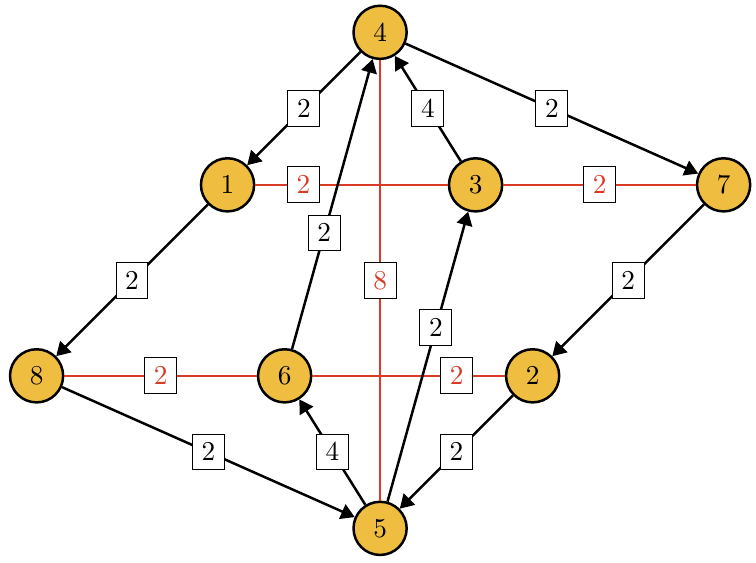
Figure 20 . Quiver diagram for phase D of Q 1 , 1 , 1 / Z 2